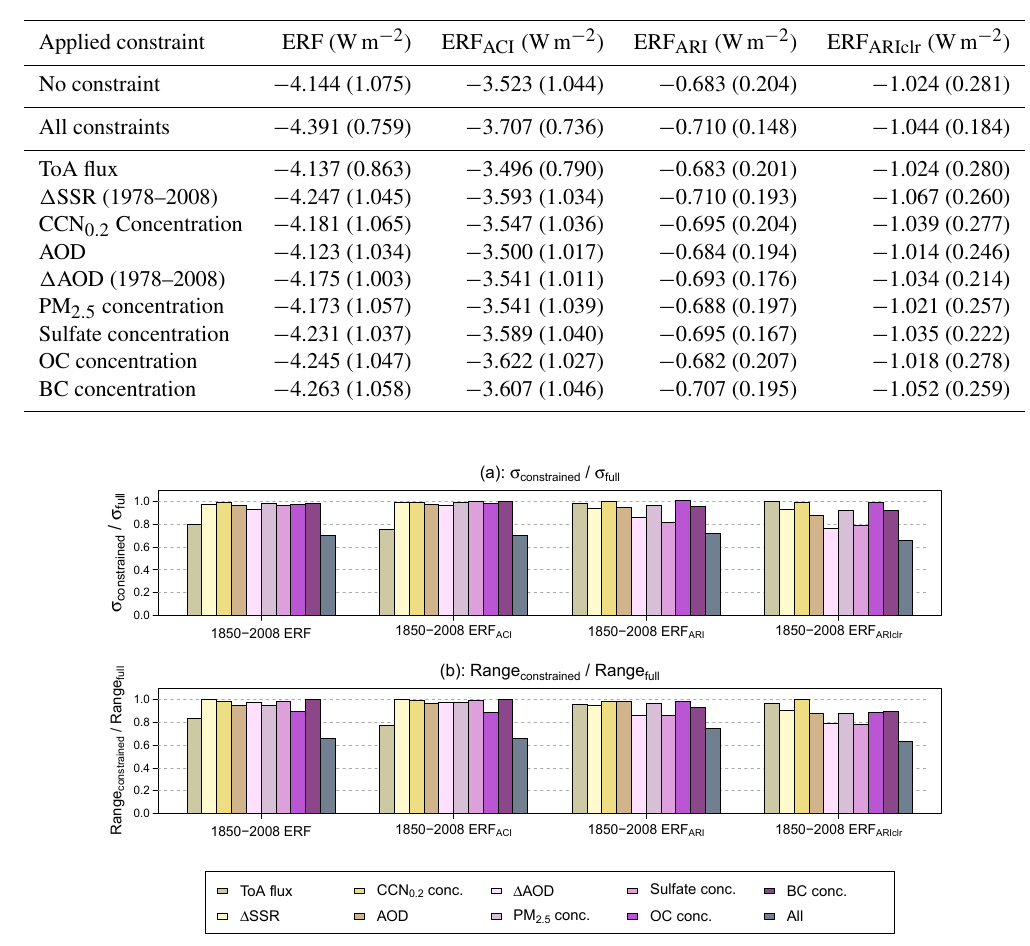
Figure 7. The relative constraint achieved for aerosol ERF, ERF ACI , ERF ARI and ERF ARIclr over Europe in July given the individual synthetic constraints applied (colours) and the simultaneous constraint (ALL). The relative constraint is evaluated as (a) the ratio of the standard deviation of the forcing in the constrained sample ( σ constrained ) to the standard deviation of the forcing in the original, unconstrained sample ( σ full ); (b) the ratio of the constrained forcing range (range constrained ) to the unconstrained forcing range (range full